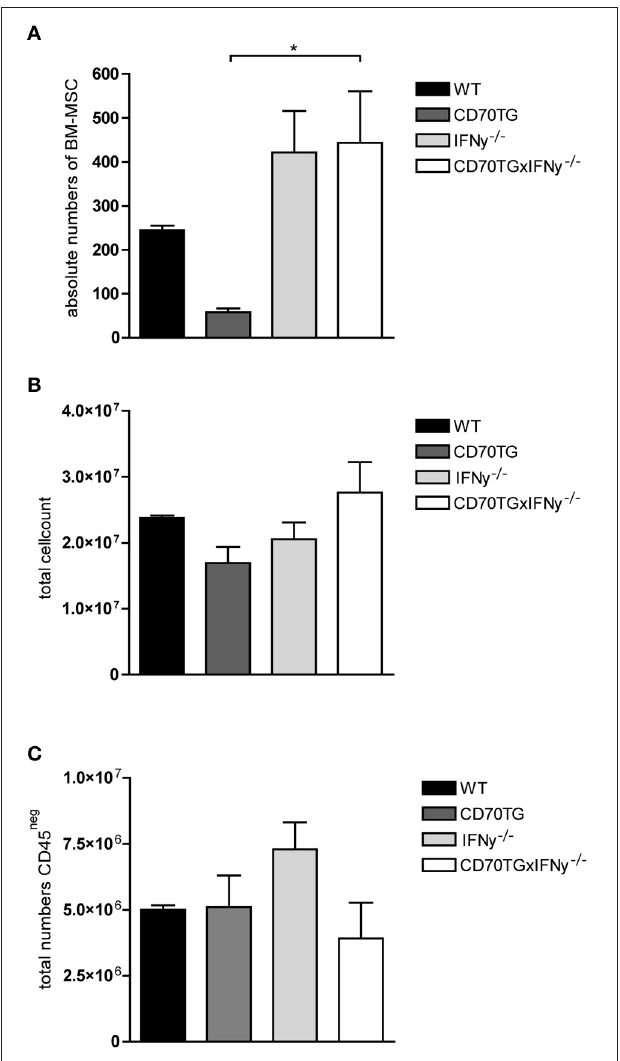
FIGURE 4 | Chronic immune activation depletes MSCs from the bone marrow. (A) Absolute numbers of MSCs in bone marrow in WT, CD70TG, and CD70TG/IFN-y − / − mice. (B) Total cell count, and (C) absolute numbers of CD45 neg cells in bone marrow of WT, CD70TG, and CD70TG/IFN-y − / − mice. Data represent mean ± SEM of 3 animals per group (ANOVA; ∗ p < 0 .